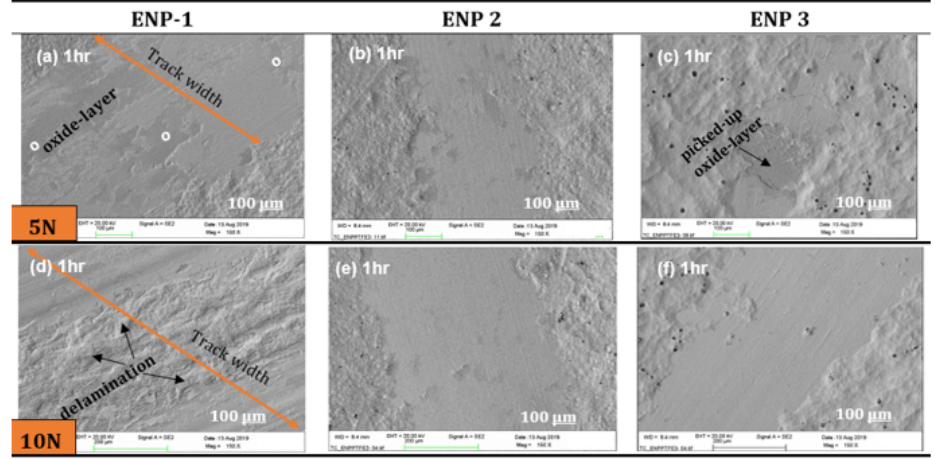
Figure 13. SEM surface micrographs of the worn tracks from 5 N and 10 N test loads on the ENP+PTFE: ENP1, ENP2 and ENP3 duplex coatings at 12,000 sliding cycles.